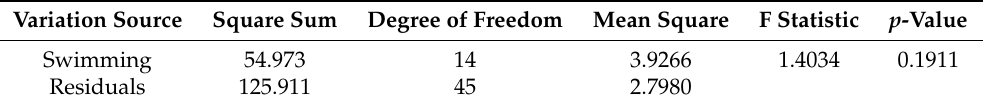
Table 6. ANOVA for THMs.